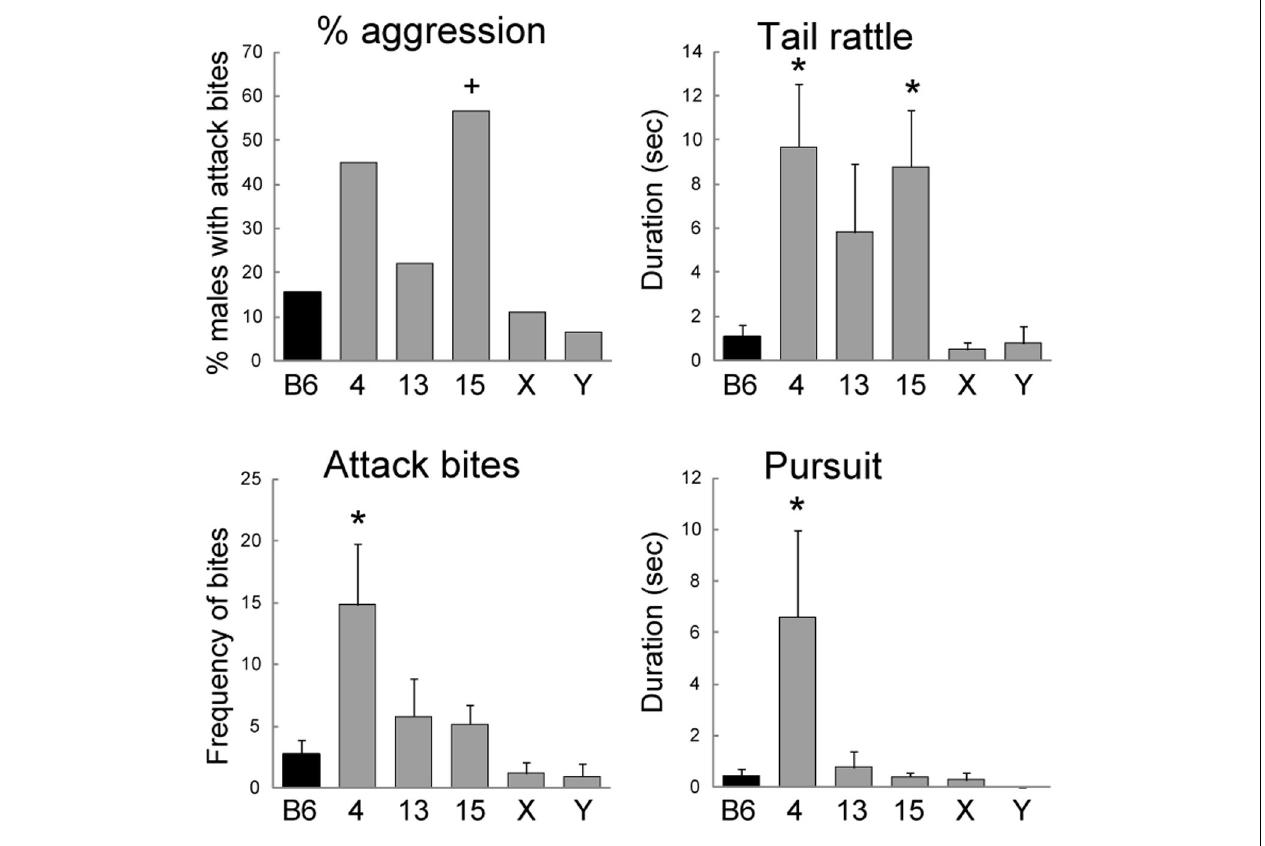
FIGURE 3 | Aggressive behaviors of consomic strains of MSM in the resident-intruder test. The numbers (4, 13, 15) and letters (X, Y) indicate the chromosome that was substituted for that of